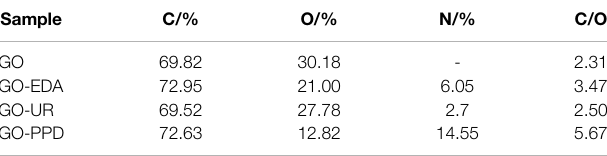
TABLE1| ElementalanalysisofGO/MCE,GO-EDA/MCE,GO-UR/MCE,andGO- PPD/MCE fi lms.